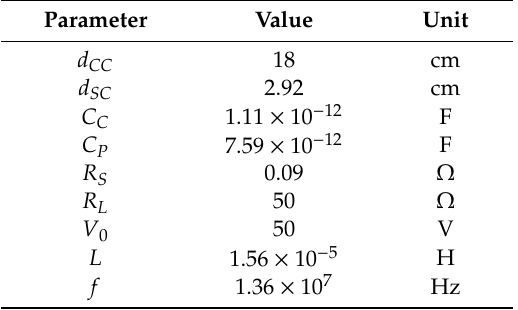
Table 5. Parameters of the shielded-CPT system for the design example.